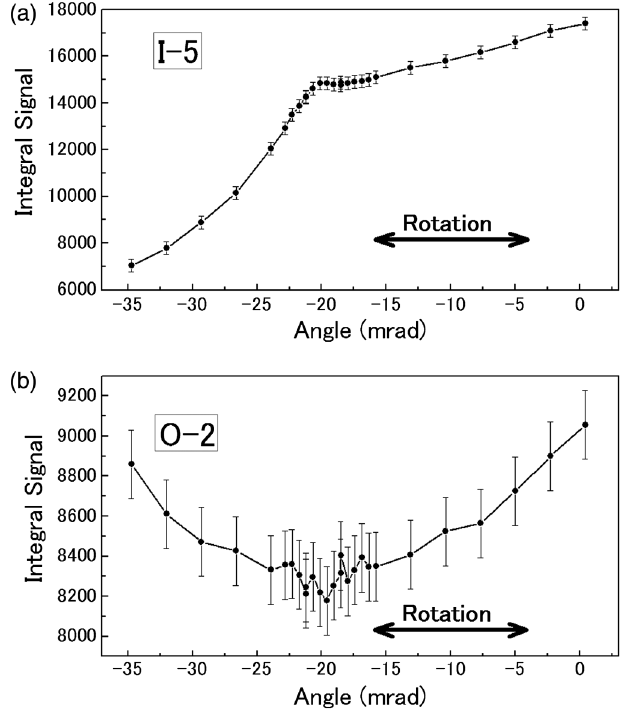
FIG. 12. Loss dependence on the angle of the inside absorber at (a) I-5 and (b) O-2. The horizontal axis corresponds to the angle of the absorber and the vertical axis corresponds to the loss caused by foil